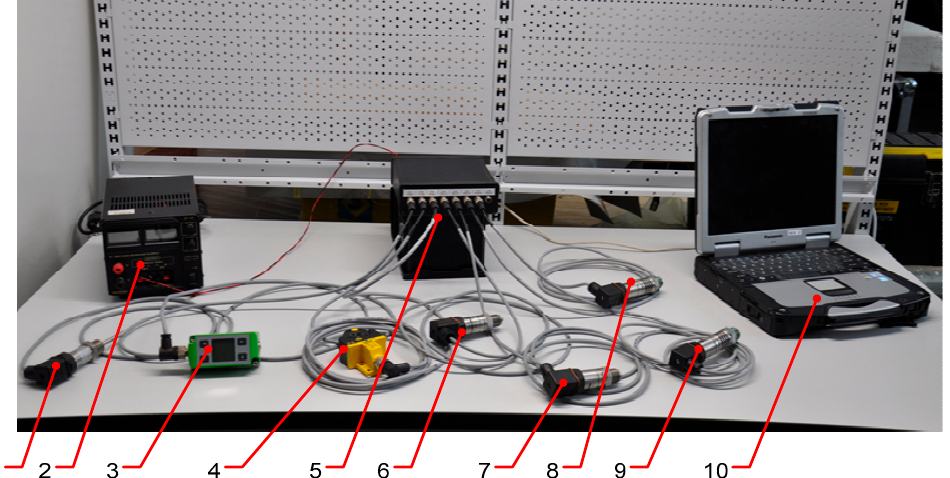
Figure 6. Measuring system with a set of sensors: 1—temperature sensor TP 995/A, 2—power supply, 3—thermodynamic flow meter EE741, 4—angular position sensor, 5—PSA-24mA analog signal converter, 6, 7, 8, 9—pressure sensors TPXG16, 10—computer.